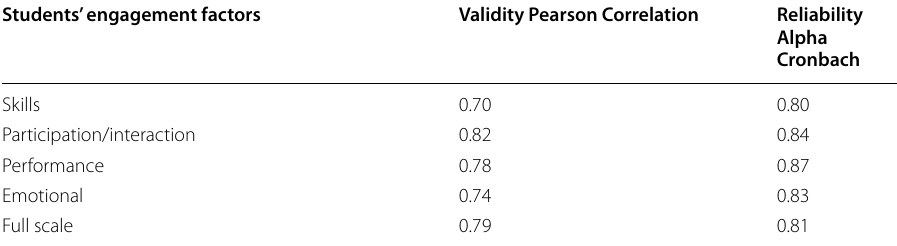
Table 2 Correlation coefficient and Cronbach’s Alpha of engagement scale Students’ engagement factors